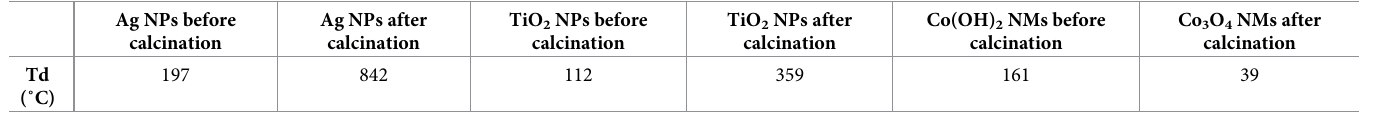
Td, decomposition temperatures at which the materials lose 5% of their